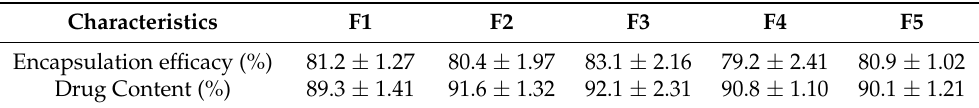
Table 2. Encapsulation efficiency and drug content of prepared hydrogels Formulations (F1–F5). Characteristics F1 F2 F3 F4 F5 Encapsulation efficacy (%)